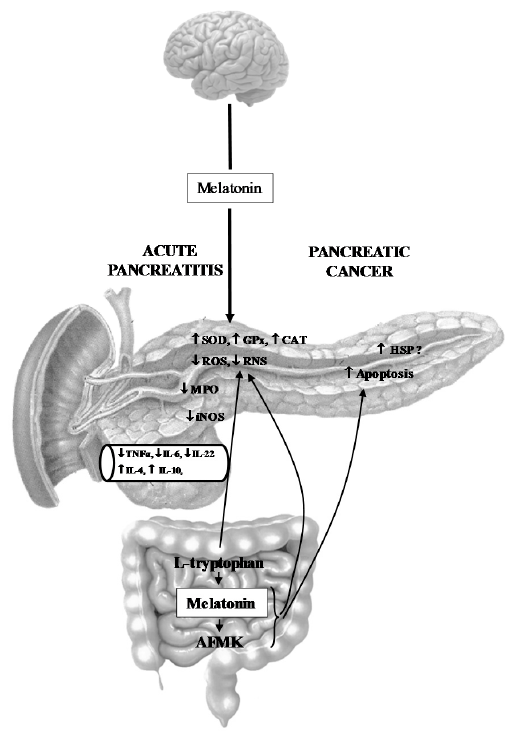
Figure 2. Effect of melatonin and its analogues on acute pancreatitis and on pancreatic tumorigenesis. CAT: catalase; GPx: glutathione peroxidase; HSP: heat shock protein; IL: interleukin; iNOS: inducible nitric oxide synthase; MPO: myeloperoxidase; ROS and RNS: reactive oxygen and nitrogen species; SOD: superoxide dismutase; TNF α : tumor necrosis factor α , AFMK: N 1 -acetyl- N 1 -formyl-5-metoxykynuramine, up arrow: effect of melatonin and its analogues on inflammatory mediators in acute pancreatitis and on molecular mechanism of pancreatic tumorigenesis, ?: possible activation of HSP by melatonin and AFMK, down arrow: pineal melatonin alleviated acute pancreatitis.